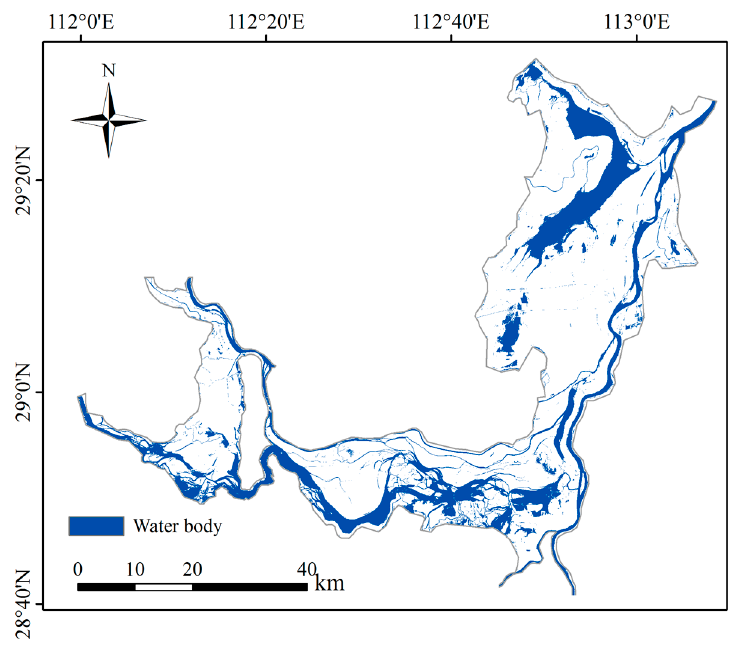
Figure 12. The water surface area of Dongting Lake in the dry season (2006).